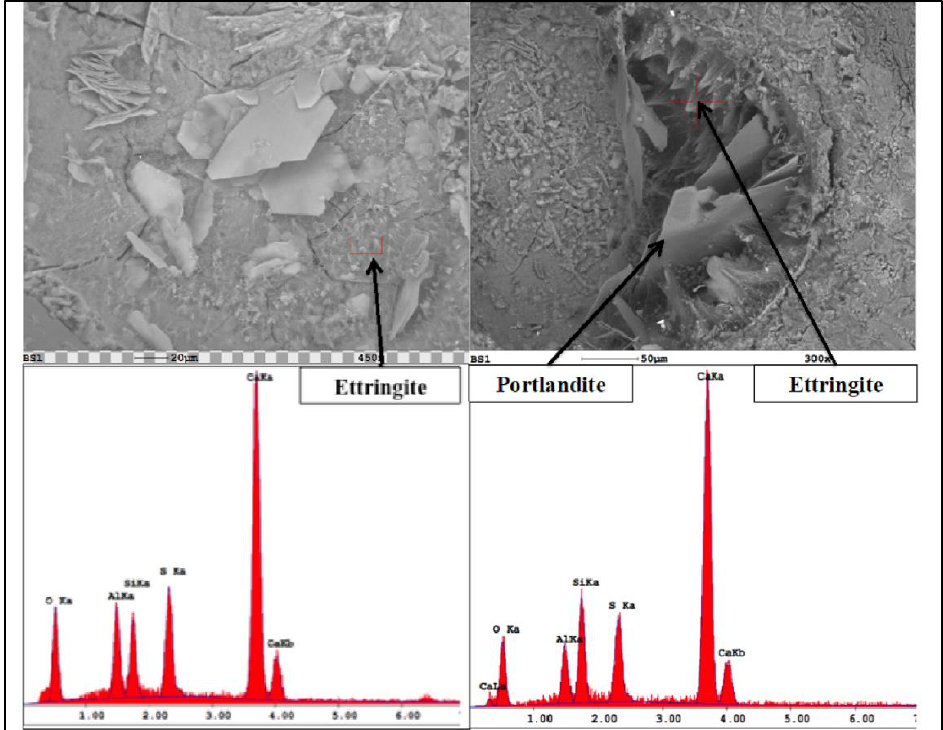
Figure 5. SE images coupled with EDS spectrums showing C1 mixture after 4 months exposure in: ( a ) 5% Na 2 SO 4 ; and ( b ) 0.89% Na 2 SO 4